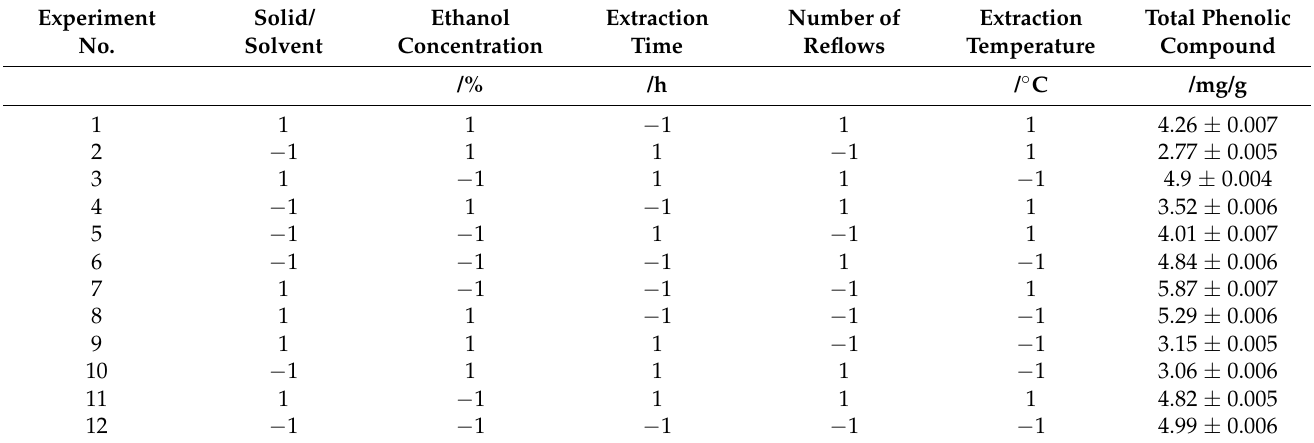
Table 2. Plackett–Burman experimental design matrix and results.